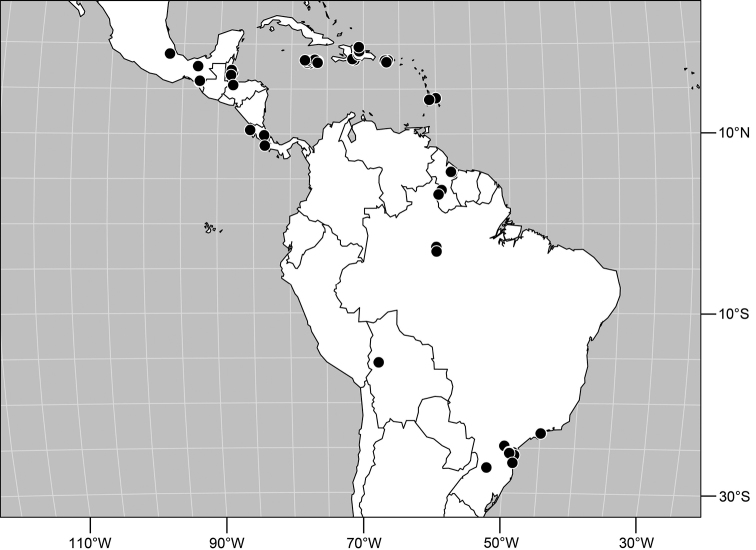
Distribution of Polytrichophora setulosa (Cresson).